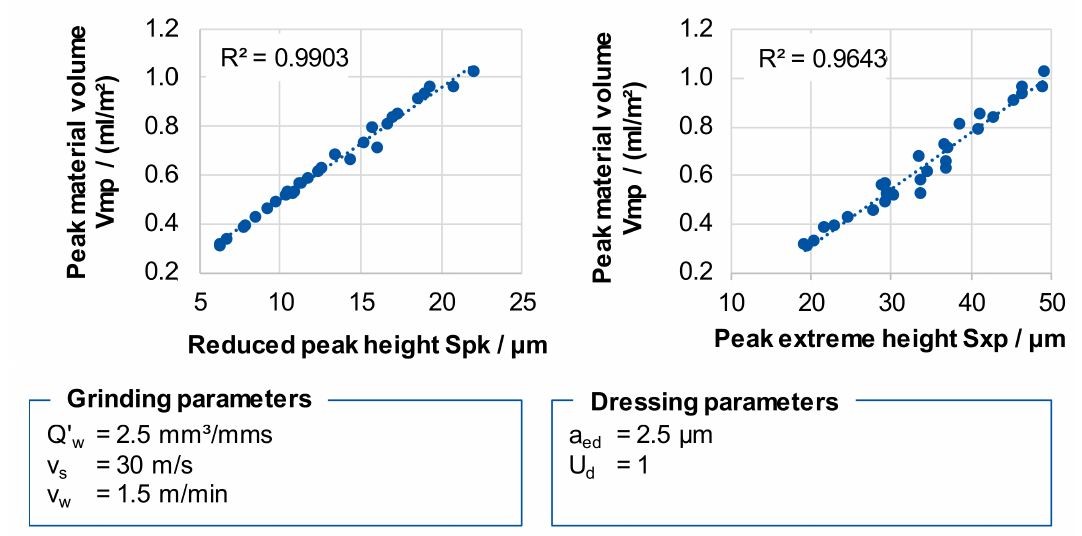
Figure 6. Correlation between the peak material volume, the reduced peak height and the peak extreme height.